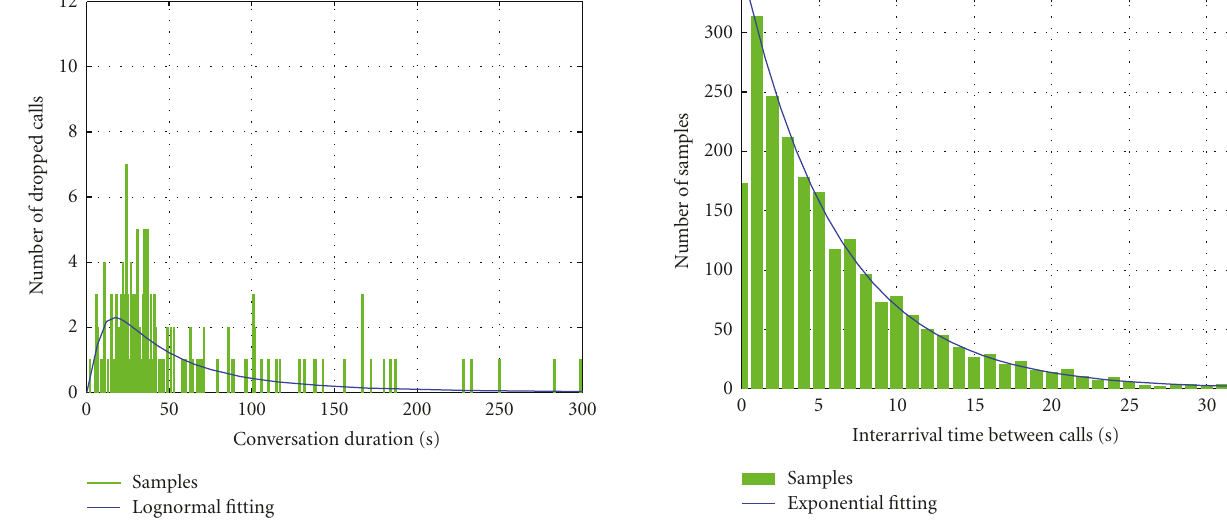
Figure 8: Fitting of interarrival time between calls with an expo- nential pdf (cell 1 observed for 4